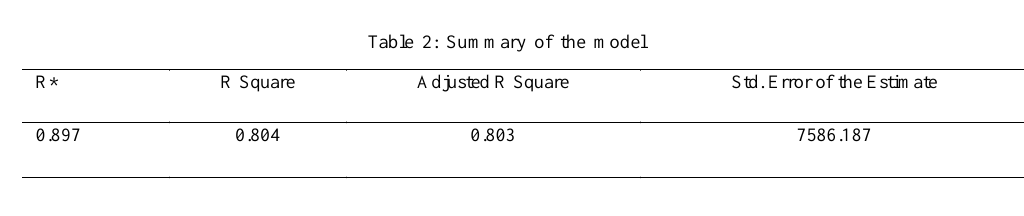
Table 3: The test of ANOV